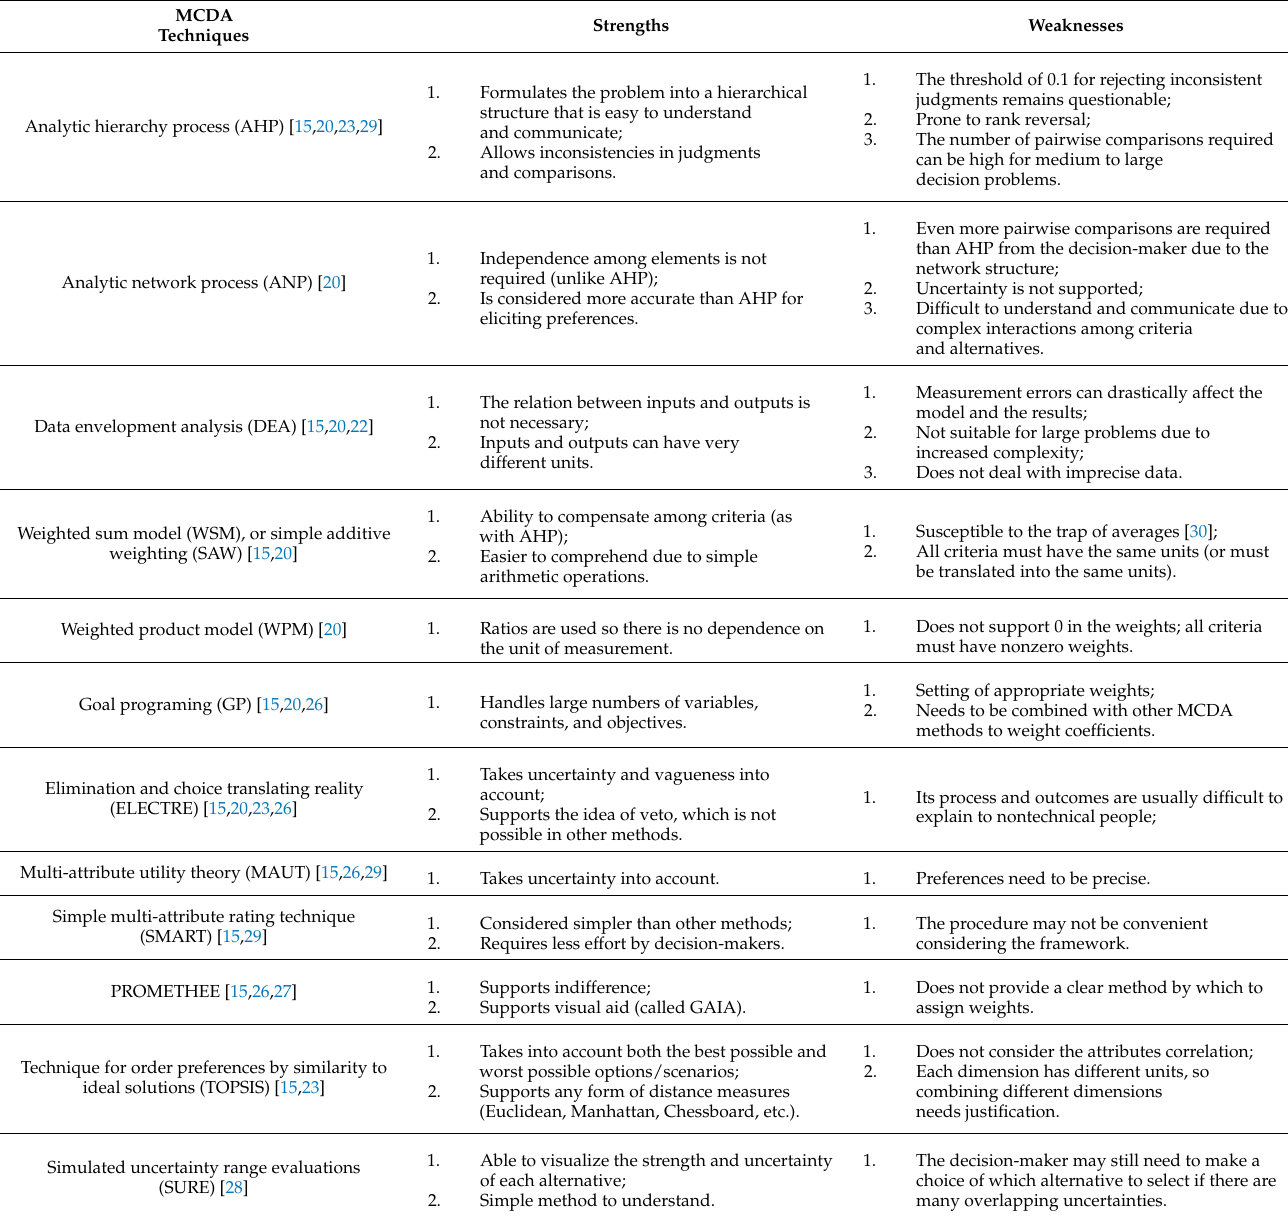
Table 3. Strengths and weaknesses of MCDA